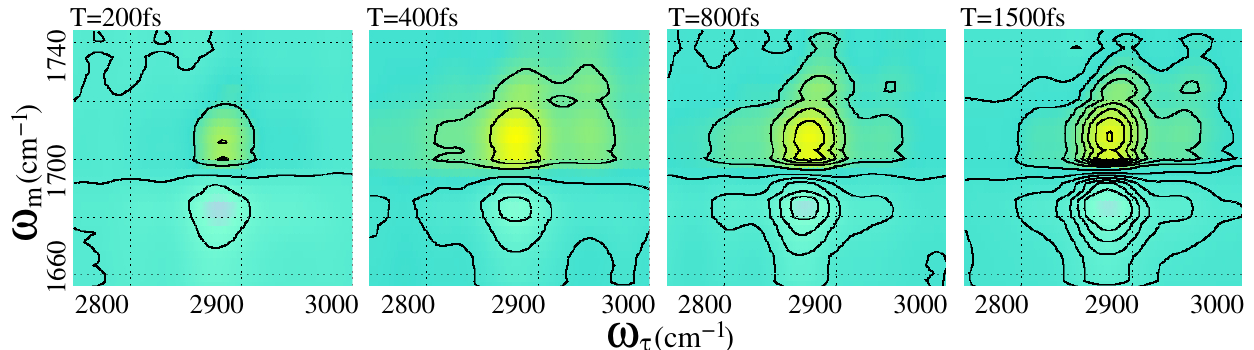
Figure 12. 2DIR spectral snapshot of 2-Pyrrolidinone at a waiting time of 200fs, 400fs, 800fs, and 1500fs. All peaks are normalized with respect to the highest intense peak in Figure 10. At an early waiting time, off-diagonal peaks are not prominent. With the development of the waiting time, the off-diagonal peak intensity grows and reaches saturation.